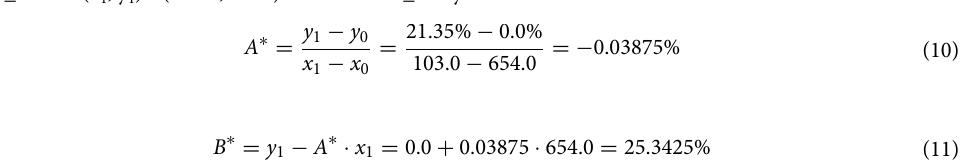
Figure 2d–f displays slice 119 of scan LFD_5 as an example of a slice Y r,l with low d α and with low τ α * as well. This suggests the hypothesis of the threshold t FM to be robust against fluctuations of τ α . Figure 2b is a scatterplot of μ Yr (ln S α ) vs. D α for α = 1. As in Fig. 2a we see a relation, not a functional graph but a ‘formed cloud’ filling one corner of the first quadrant. In analogy to Fig. 2a we see on Fig. 2b high values of μ Yr (ln S α ) seem to force low values of D α [see (12A)], contradicting intuition (S), whereas high values of D α constrain low values of μ Yr (ln S α ) [see (12B)] contradicting (S) as well. The third corner of the triangle meets intuition (S): low μ Yr (ln S α ) coincides with low D α [see (12C)].